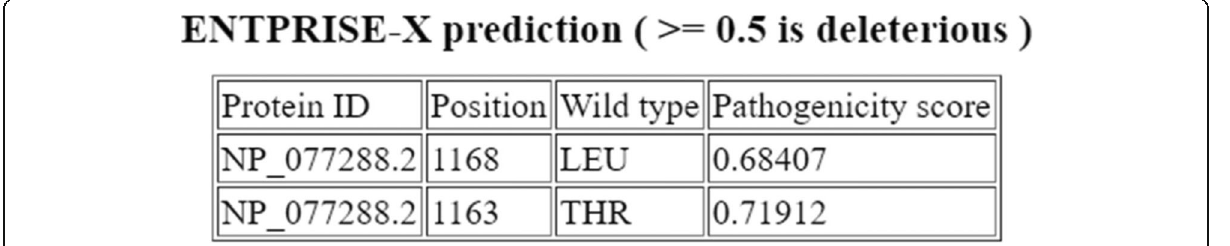
Fig. 7 Enterprise-X tool report comparing the pathogenicity of the two frameshift mutations in exon 19 of GNPTAB gene ; the reported p.L1168QfsX5 mutation and the novel single base deletion p.T1163KfsX2